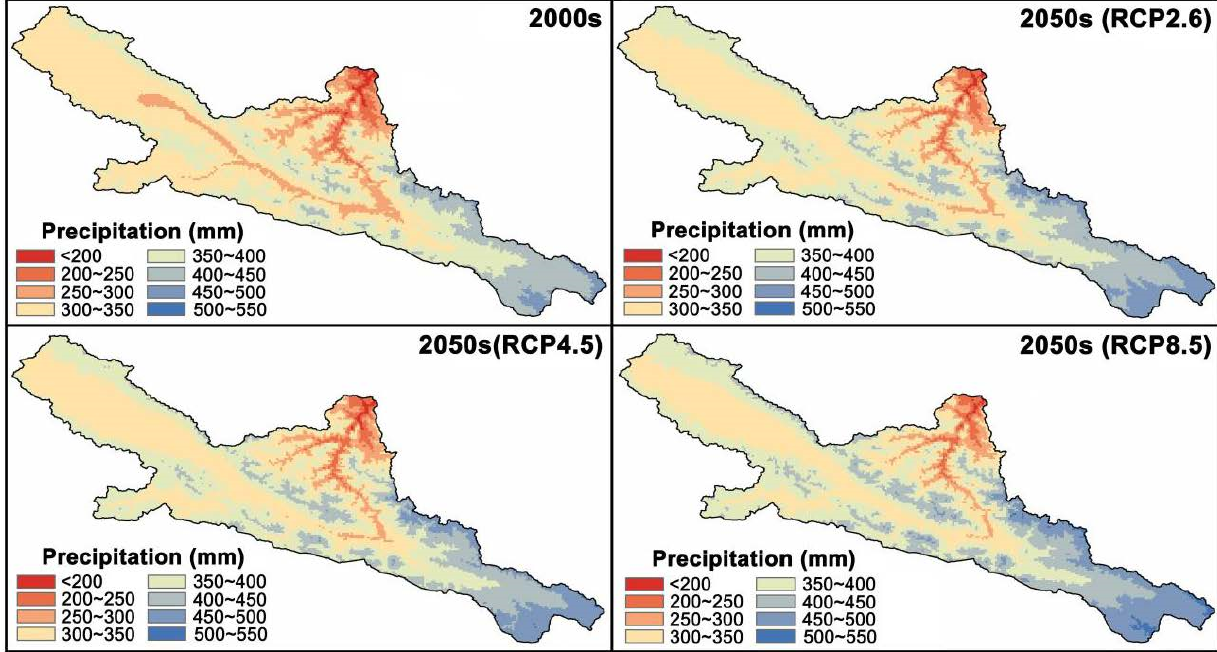
Figure 2. Distribution of mean annual temperature for the 2000s (1970–2000) and 2050s under the three representative concentration pathways (i.e., RCP2.6, RCP4.5 and RCP8.5) in the study area.